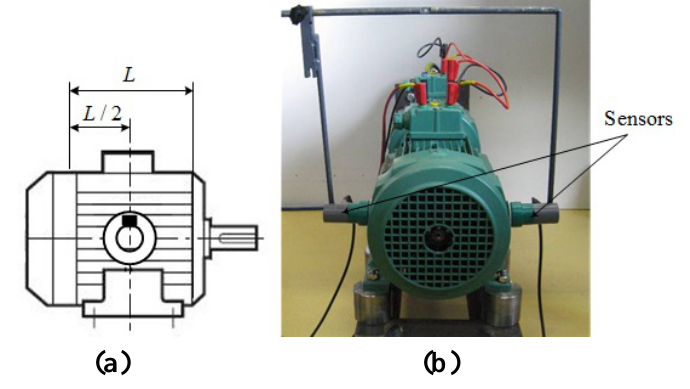
Figure 2. Sensor positions for measuring the transversal external magnetic